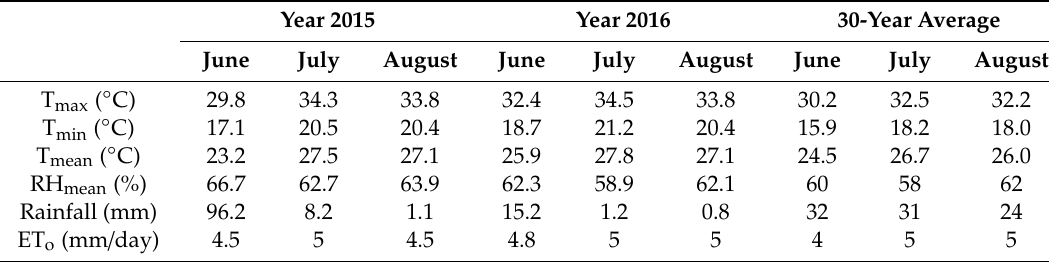
Table 1. The main weather parameters (mean relative humidity (RH mean ), rainfall, maximum (T max ), minimum (T min ), and mean (T mean ) temperature), and reference evapotranspiration (ET o ), for the two years and its comparison to the 30-year average. The weather data were recorded with an automatic weather station close to the experimental